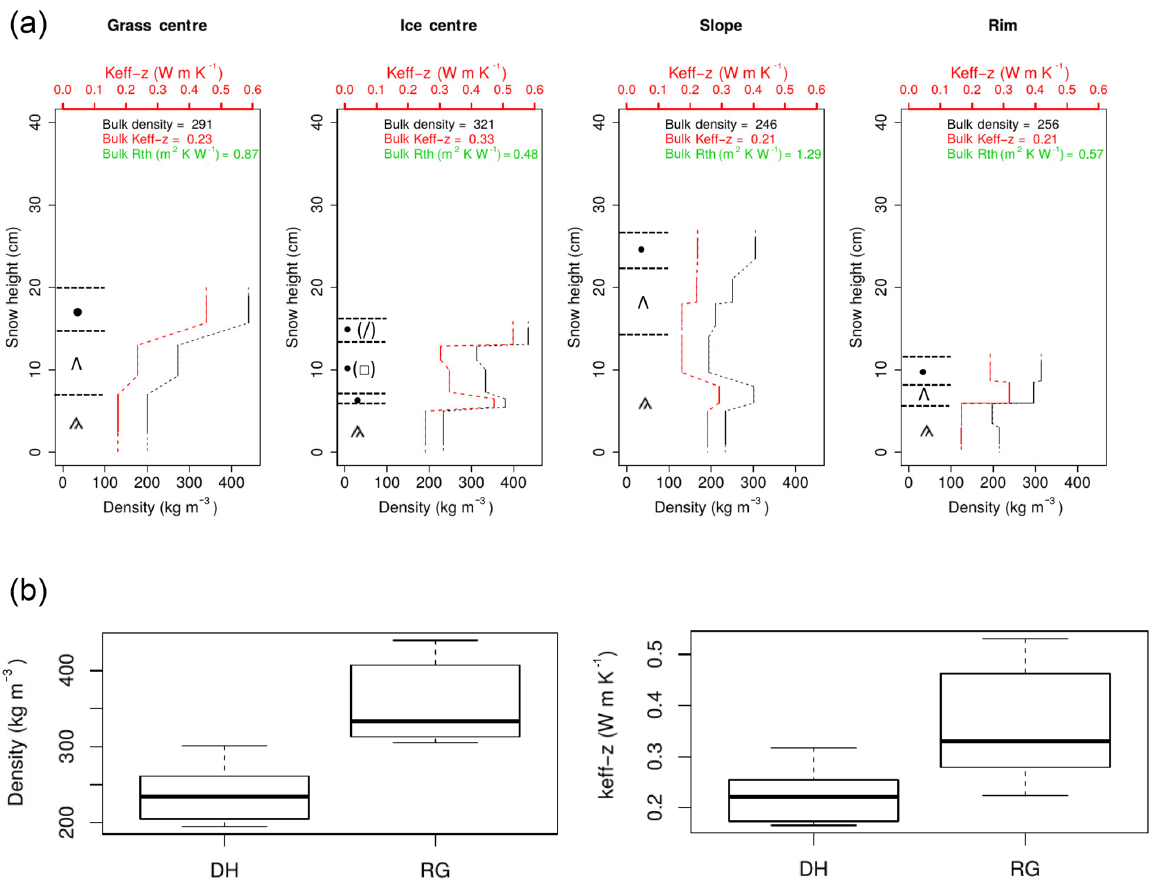
Figure 3. (a) Grain shape, density, and K eff − z profiles from the four CT sites. Density and K eff − z values are represented by piecewise constant functions over the layers where the CT analysis was performed; these segments are connected by a dashed line as a guide to the eye. Symbols for the grain shapes originate from Fierz et al. (2009). When several grain shapes coexist within a layer, the dominant type is listed first. (b) Box plots of density and K eff − z for individual DH layers (11) and rounded grain (RG) layers (eight) found within the CT profiles. RG shapes were occasionally associated with faceted crystals and decomposing and fragmented precipitation